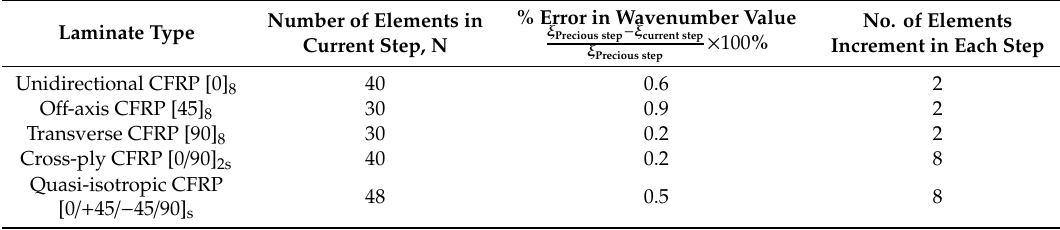
Figure 23. Convergence of SAFE method in the 1-mm quasi-isotropic [0 /+ 45 / − 45 / 90] S CFRP composite plate: 0.5% accuracy in the highest wavenumber-frequency pair of the evanescent kind can be obtained with N = 48 SAFE elements across the thickness. The trend line is an exponential fit. Table 3. Number of SAFE elements across the thickness to obtain at least 1.0% convergence for the highest wavenumber-frequency pair in evanescent mode in various CFRP composite